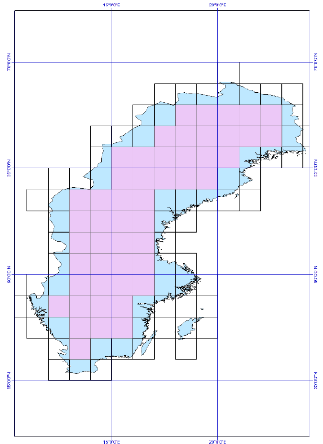
Figure 3 . An example demonstrate the dynamic request decomposition.